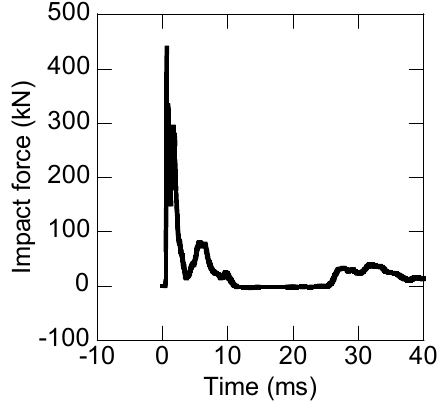
PE / Fig. 11. Maximum displacements depending on E col /P u . mcol